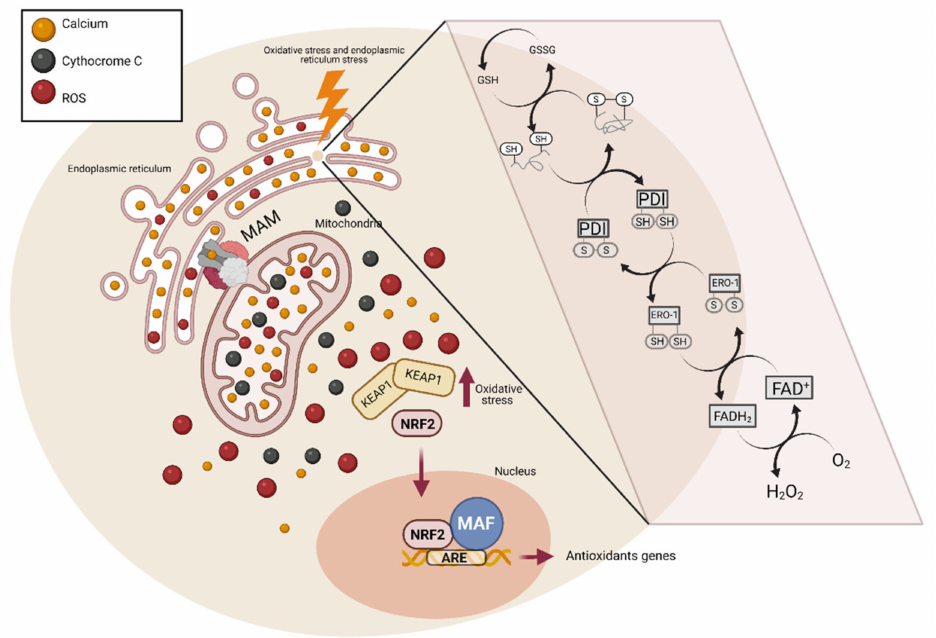
Figure 3. The connection between oxidative stress and endoplasmic reticulum stress. The presence of reactive species inside the endoplasmic reticulum favours the formation of the disulphide bonds in the protein folding. When this occurs, two electrons are released and accepted by protein disulphide isomerase (PDI), which loses its original conformation, accumulating inside the endoplasmic retic- ulum (ER) and triggering ER stress. PDI then releases two more electrons that are accepted by ER oxidoreductase (ERO1). Finally, the electrons are accepted by O 2 , leading to the production of H 2 O 2 . An increase in H 2 O 2 causes Ca 2+ levels in the ER to increase. The ER and mitochondria are linked by channels called MAM. When Ca 2+ increases in the ER, it moves to the mitochondria. Elevated Ca 2+ levels in the mitochondria stimulate mitochondrial metabolism, producing even more ROS. Ca 2+ also increases the permeability of the mitochondrial membrane, allowing cytochrome C to be released and activate cellular apoptosis pathways. The increased ROS levels induce the release of Nrf2 from Keap1, translocates to the nucleus where it binds to an accessory protein, Maf. The complex formed by Nrf2 and Maf leads to the activation of antioxidant genes, interacting with an antioxidant response element